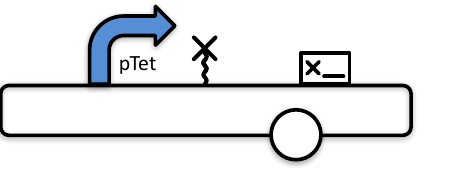
Figure 29: Promoter stored in a plasmid as in Figure 26, except that there is a ribonuclease site after the promoter rather than restriction sites flanking it.